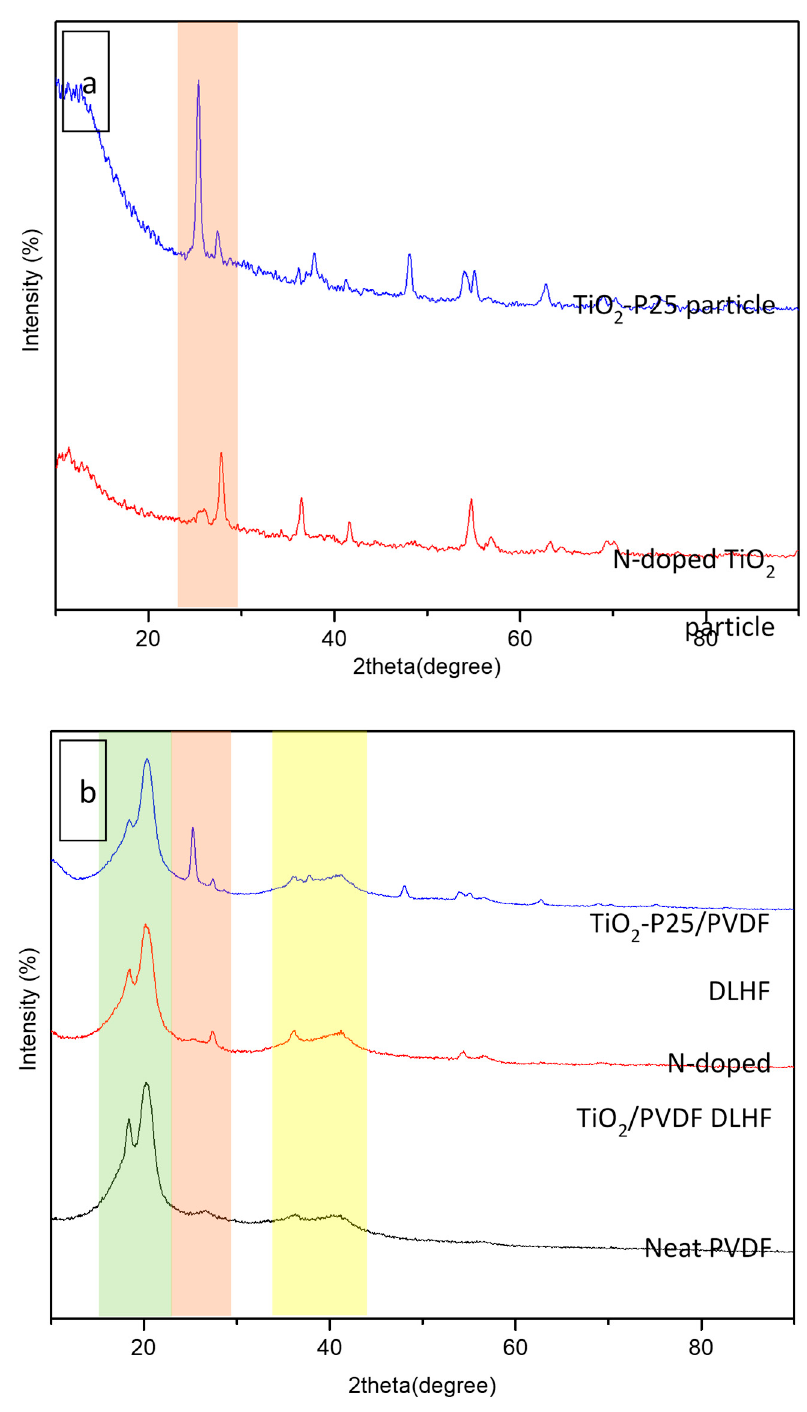
Figure 3. XRD pattern of ( a ) N-doped TiO 2 particle and TiO 2 -P25 particle ( b ) N-doped TiO 2 / PVDF, TiO 2 -P25 / PVDF DLHF and neat polyvinylidene fluoride (PVDF) membranes carried out at 40 kV and 40 mA, which employed a CuK α radiation at a wavelength of 0.15418 nm at an angular incidence of 2 θ = 20–80°.